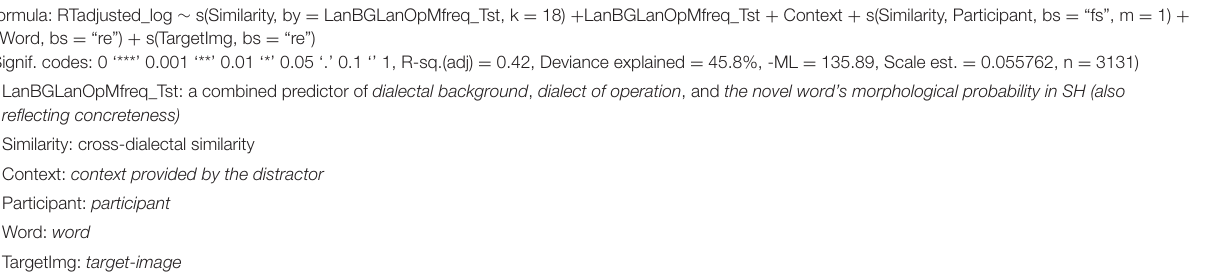
TABLE 3 | GAM model results for recognition